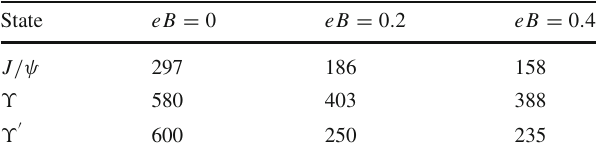
Table 1 The dissociation temperature ( T D ) for the quarkonia states (in units of MeV), when (cid:15) = 2BE